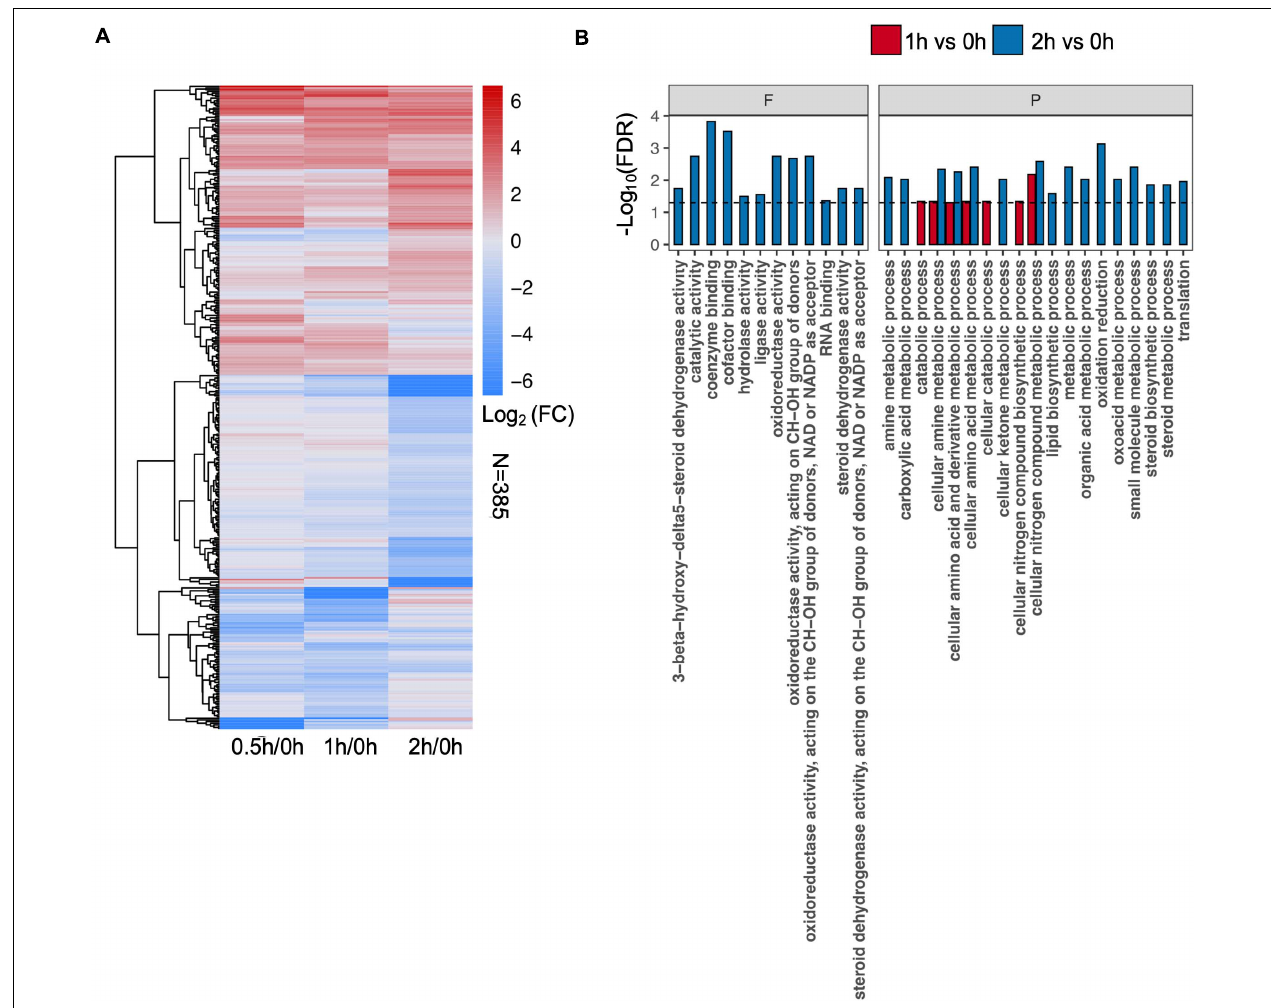
FIGURE 3 | Effect of salt treatment on the soybean ( Glycine max [L.] Merr.) accession C08 leaf proteome. (A) Heatmap displays the log 2 -fold changes in abundance of significant differentially expressed proteins (DEPs) (stress vs. normal control), adjusted p -value ≤ 0.05. The union set was used to generate the plot. (B) Gene ontology (GO) enrichment of DEPs at each time point compared to 0 h sample. Three categories of GO terms including “cellular component,” “biological process” (P), and “molecular function” (F) were used, only items in the last two were found enriched. Dashed line indicates FDR = 0.05. The protein lists of enriched items are provided in Supplementary Table 6